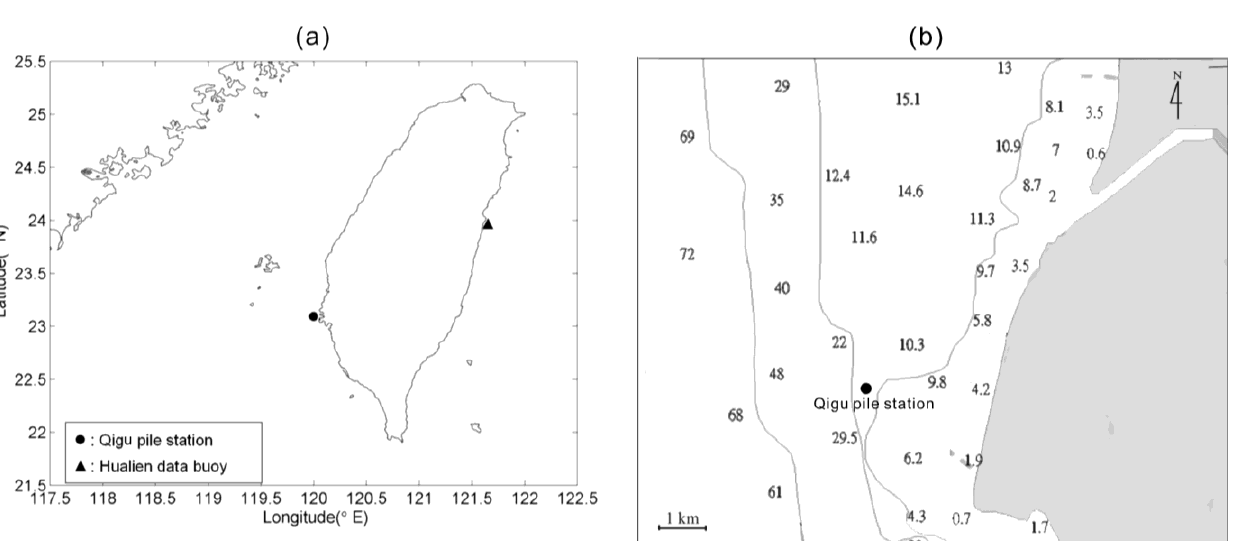
Figure 1. The location and surrounding bathymetry of the Qigu pile station. The numbers in Figure 1b stand for water depths. The pile station is located approximately 3 km from the western coast of Taiwan, where the water depth is 15